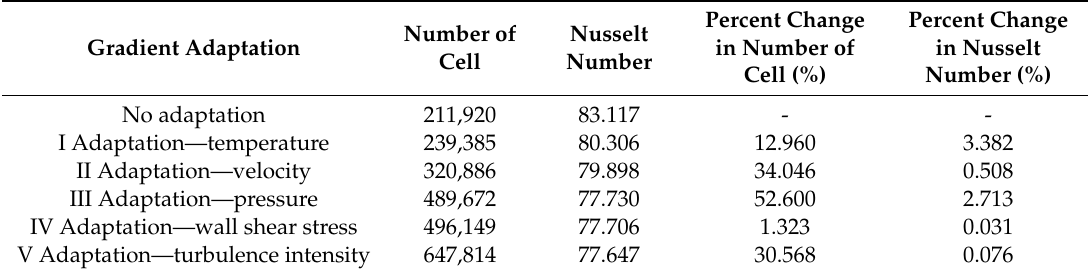
Table 3. Number of cells and Nusselt number after each gradient adaptation for a solar air heater with a transverse triangular block at the bottom of the air duct for fixed value of height ( e = 40 mm), pitch ( P = 150 mm), length ( l = 65 mm), and Reynolds number ( Re = 12,000).